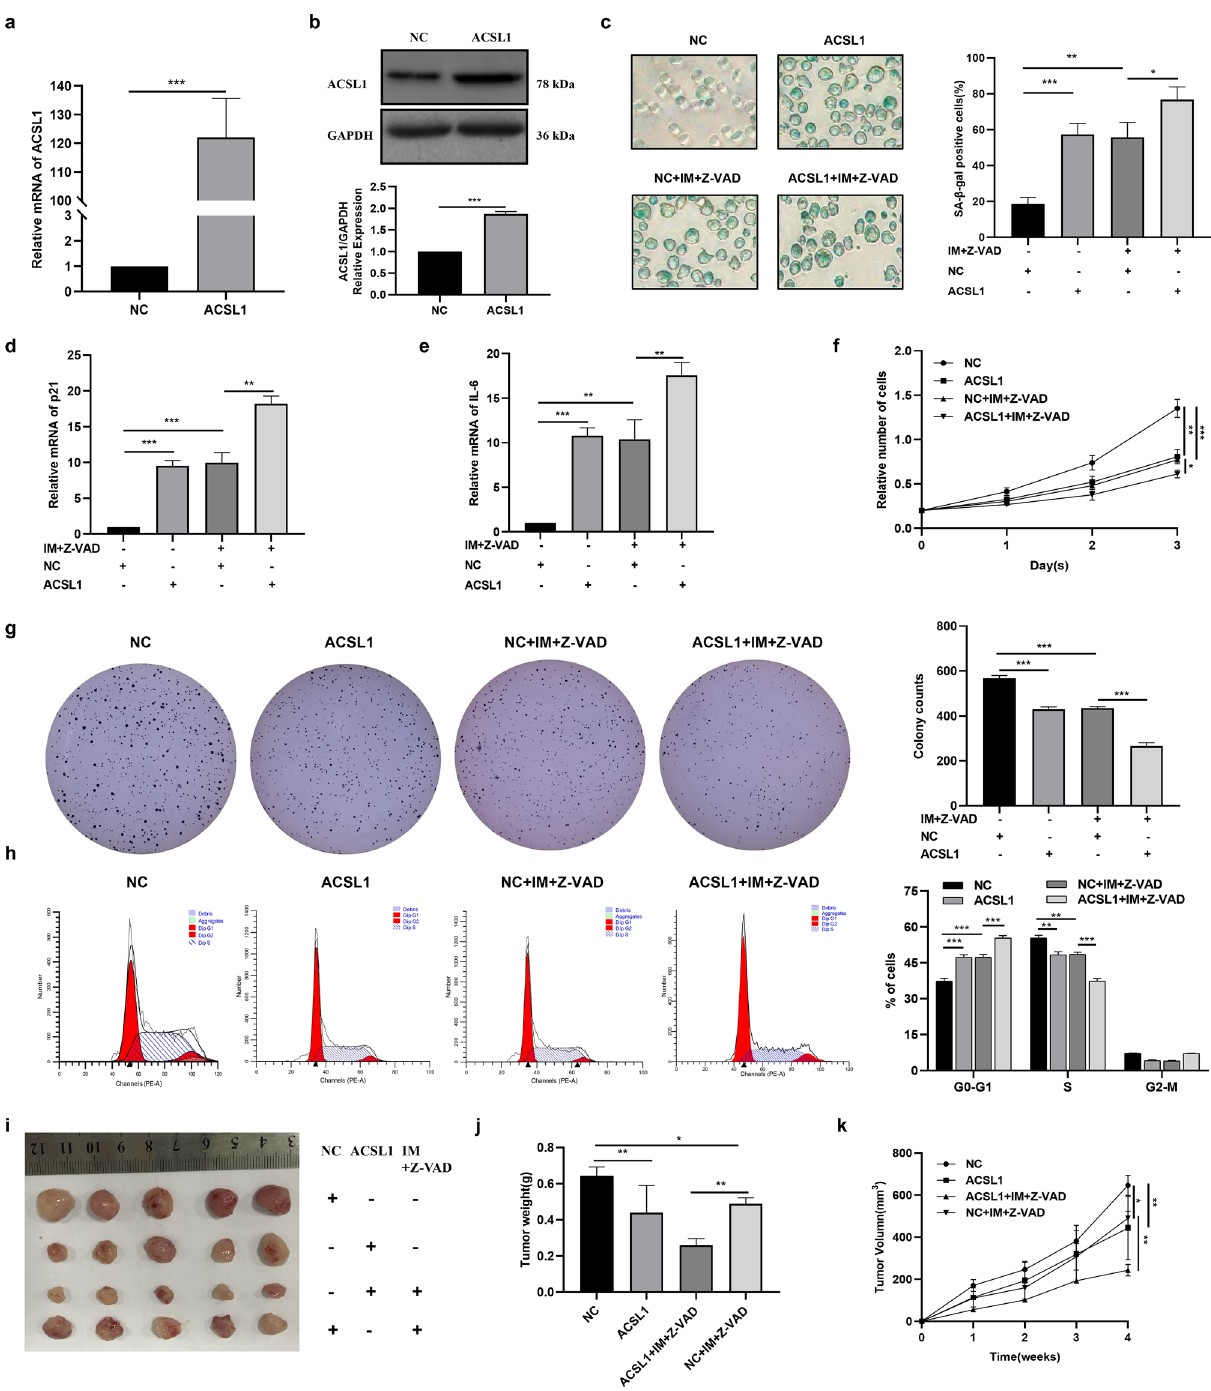
Figure 2. Overexpression of ACSL1 mediates imatinib-induced senescence in K562 cells. ( a , b ) qRT-PCR and western blot analysis verified efficiency of overexpressing ACSL1. ( c ) Cell senescence analysis determined by SA-β-gal staining. ( d , e ) qRT-PCR was applied to quantify the relative expression of senescence-associated genes p21 and IL-6. ( f ) Cell proliferation analysis determined by CCK8 assay. ( g ) Cloning formation assay indicating the in vitro growth of K562 cells. ( h ) Cell cycle distribution analyzed using PI staining followed by flow cytometry. ( i ) Representative images of tumor from a Xenograft model in nude mice. ( j ) Tumor weight of all mice in each group. ( k ) Tumor volumes were measured on the indicated days. The data are presented as the mean ± SD of three independent experiments. *p < 0.05, **p < 0.01 and ***p <